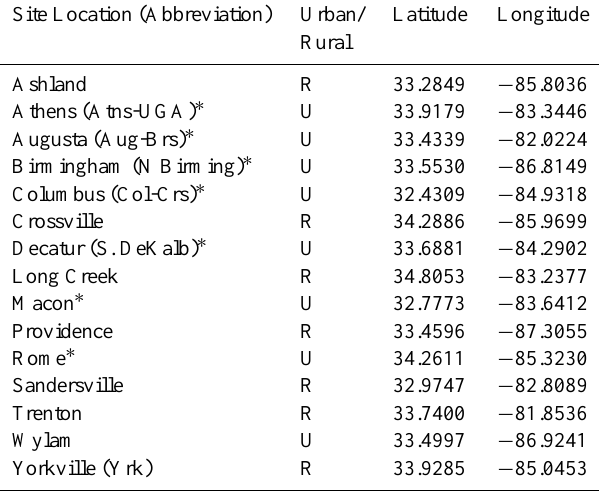
Table 1. Names and locations of the FRM sampling sites used in this study. A map is provided in Fig. 1. A subset of the sites were also speciation sites ( ∗ ) with additional measurements of aerosol components (e.g., OC, EC, and